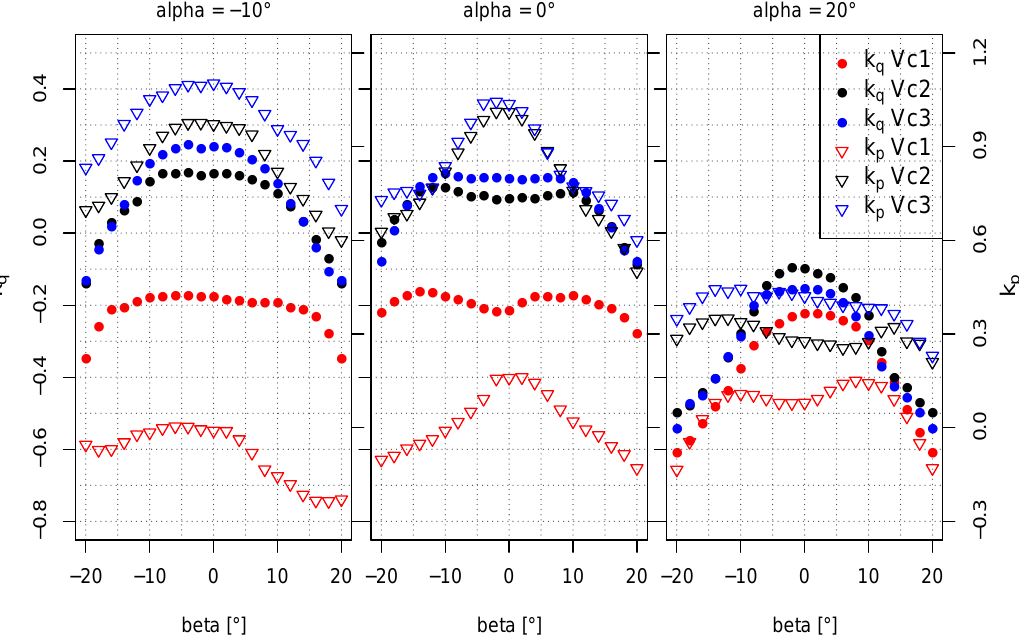
Figure 5. Dynamic pressure calibration coefficients k q and static pressure calibration coefficients k p , plotted over − 20 ◦ ≤ β ≤ 20 ◦ for the three calibration speeds v c 1 = 15 m s − 1 , v c 2 = 22.5 m s − 1 and v c 3 = 28 m s − 1 . Three examples of the calibration at α = − 10 ◦ , α = 0 ◦ and α = 20 ◦ are shown. The axis of k q is for all subplots on the left side, and k p is on the right side. The axis-labelling of the middle plot is left